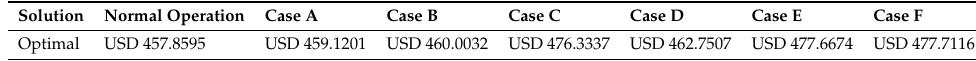
Table 1. The operating cost of generation for cases A, B, C, D, E, and F. Solution Normal Operation Case